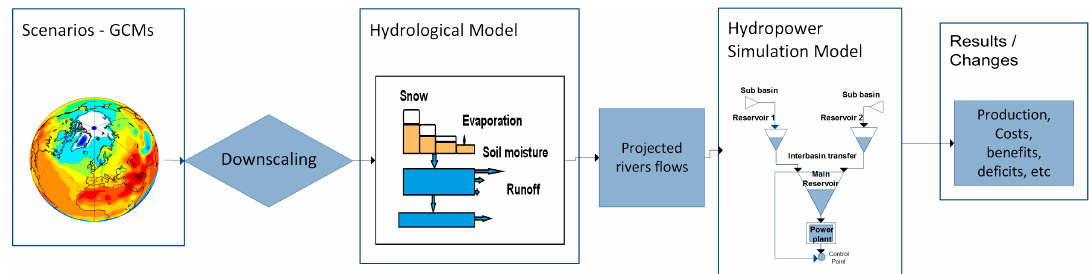
Figure 3. The method and steps used in assessing the impacts from future climate scenarios to hydropower